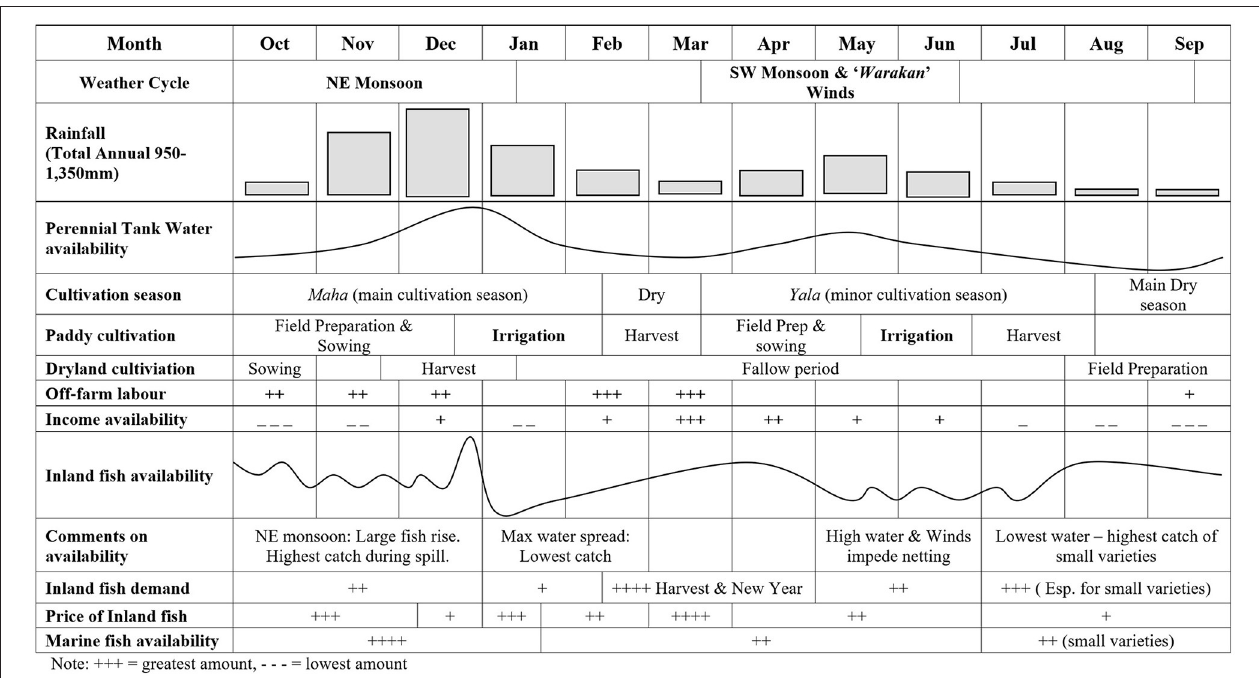
FIGURE 4 | Seasonal livelihood calendar (farmers) and fish demand and supply trends, Galgamuwa and Anamaduwa Districts, North West Province. Source : Interviews with farmers, fish producers and vendors.